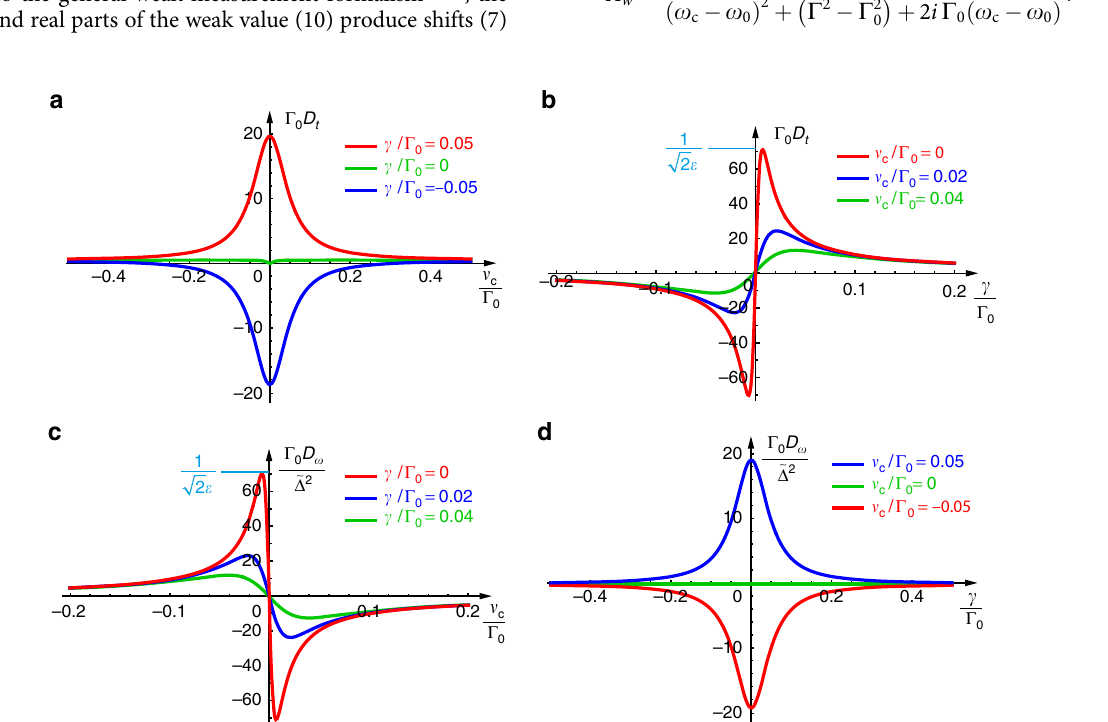
Figure 3 | Theoretically calculated time and frequency shifts of an optical pulse transmitted through a waveguide-coupled resonator. Time ( a , b ) and frequency ( c , d ) shifts of the transmitted pulse, D t and D o , described by the weak measurement equations (11) and (12), versus frequency and coupling detunings, n c ¼ o c (cid:3) o 0 and g ¼ G (cid:3) G 0 . The shifts are strongly enhanced near the critical-coupling (zero-transmission) point ( n c , g ) ¼ (0,0). The adiabatic parameter is taken here as e ¼ 0.01. The normalization constants are chosen in such a way that the dimensionless shift values indicate their enhancements over the typical shifts (without critical coupling). The extreme values of the dimensionless shifts ( ’ (cid:8) 1 = ffiffiffi 2 in the red curves in b , c . NATURE COMMUNICATIONS|7:13488|DOI: